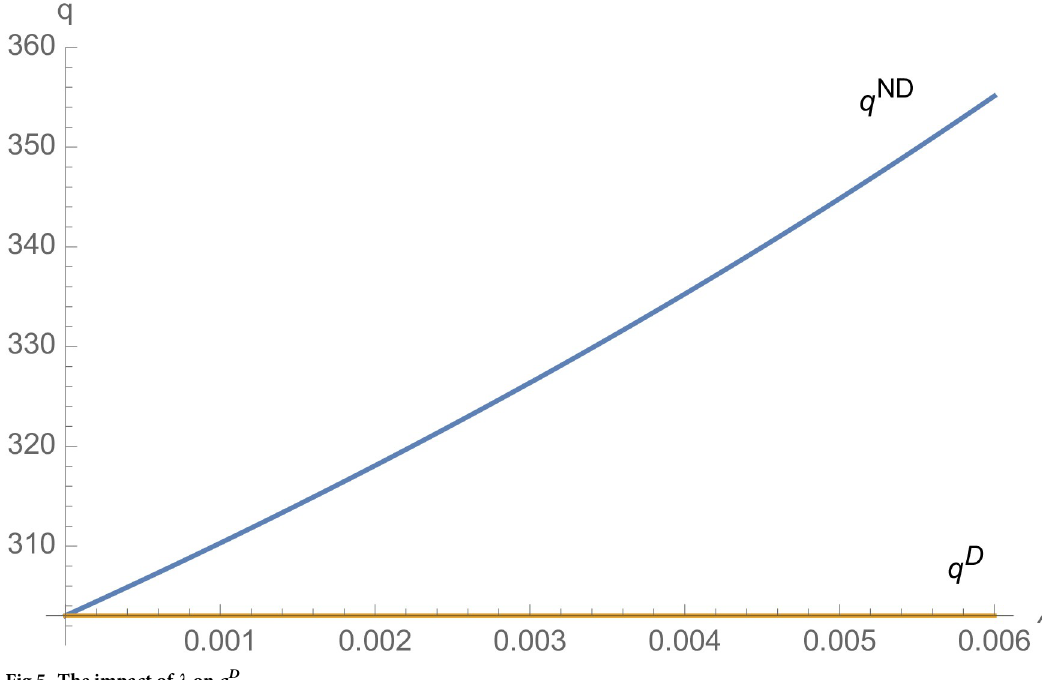
Fig 5. The impact of λ on q D .